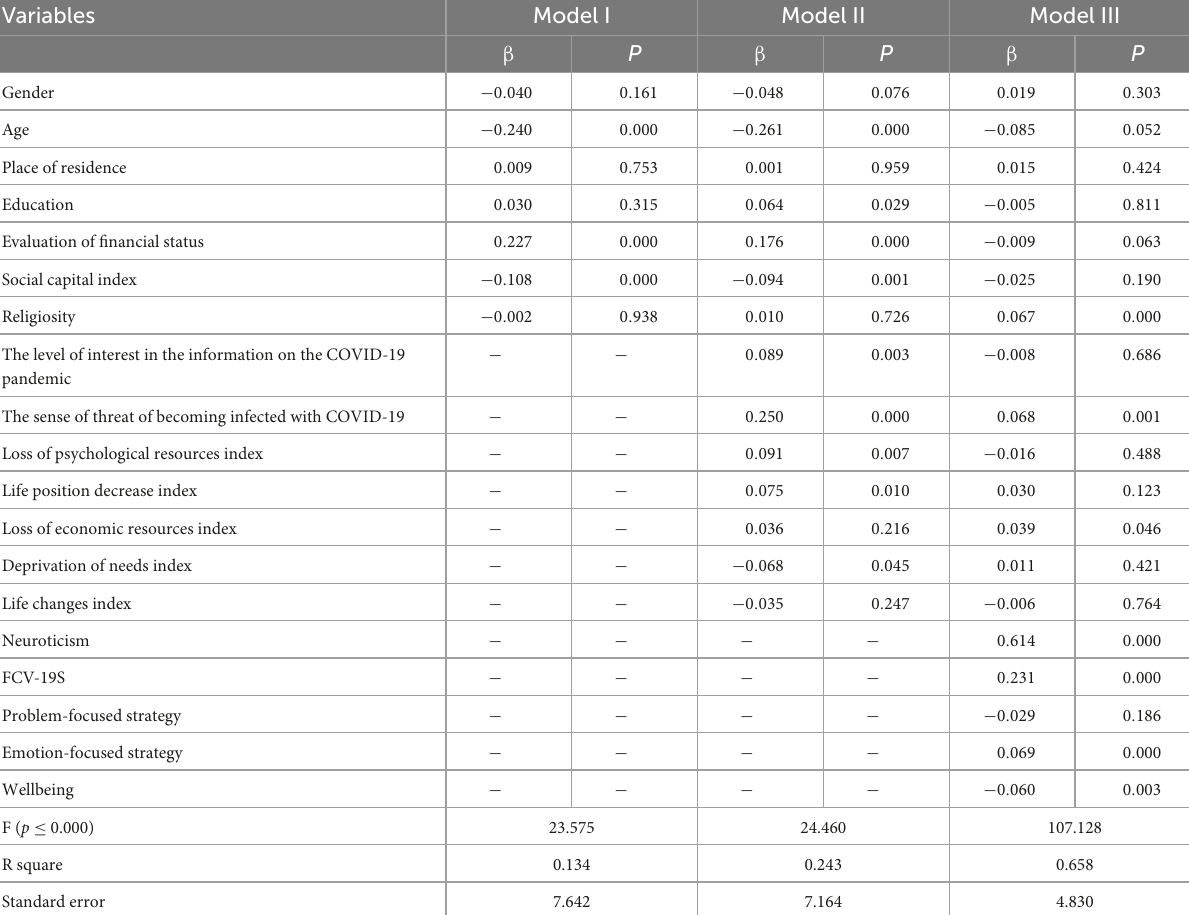
TABLE 7 Results of multiple regression analyses predicting the level of psychological distress.